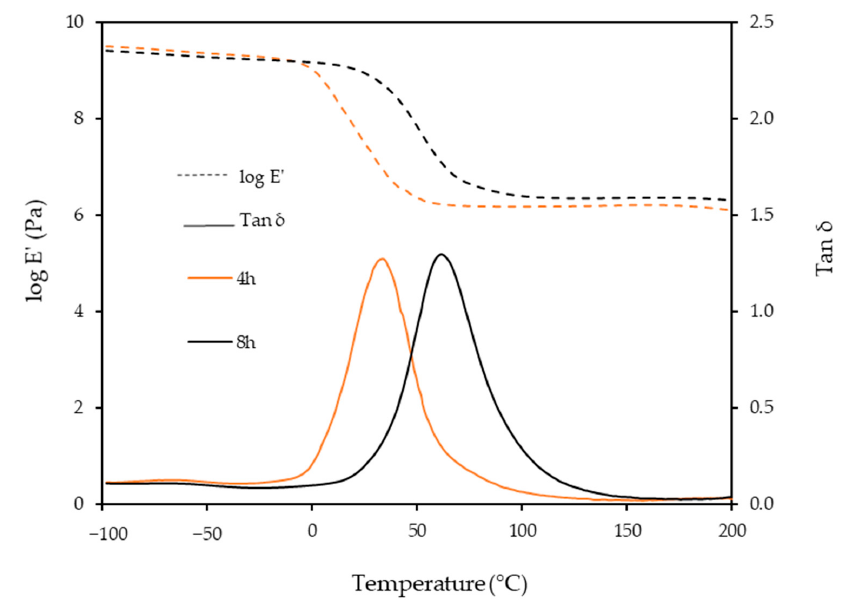
Figure 4. Dependence of storage modulus, E ′ and tan δ of BIO-PU0.6 films on temperature with different heating times.